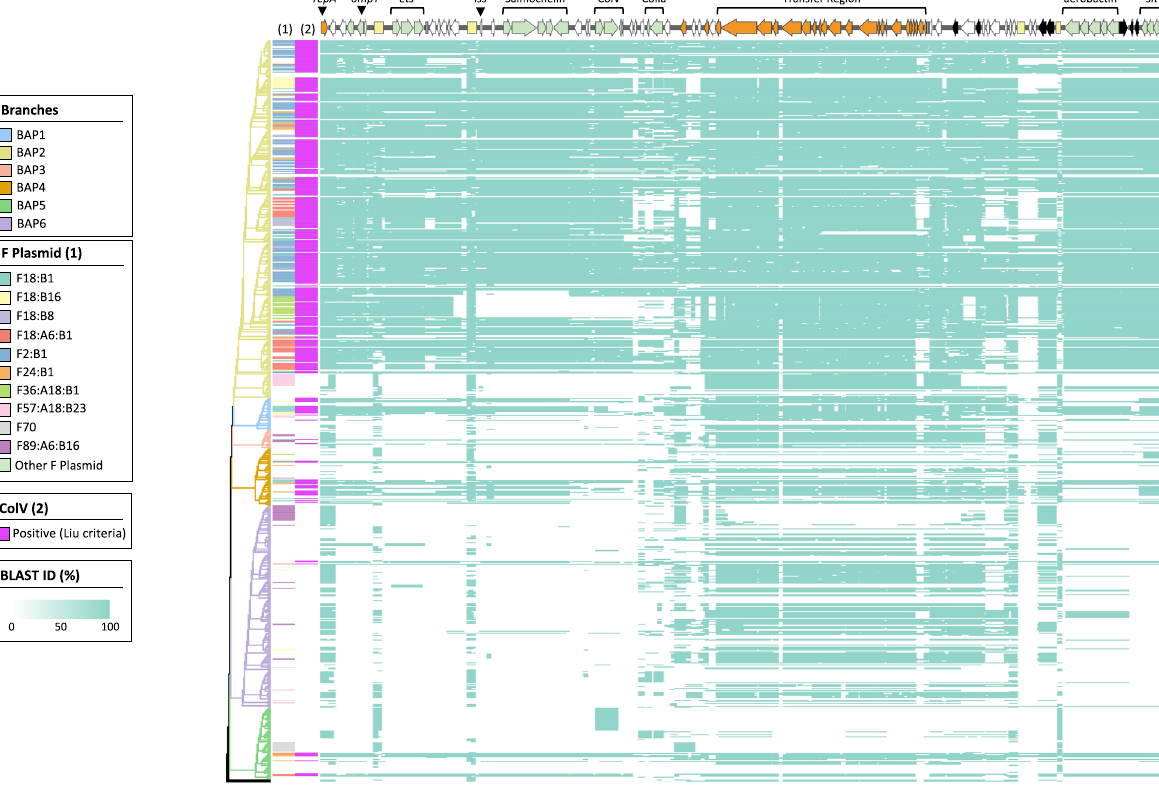
NATURE COMMUNICATIONS| (2022) 13:683 |https://doi.org/10.1038/s41467-022-28342-4|www.nature.com/naturecommunications